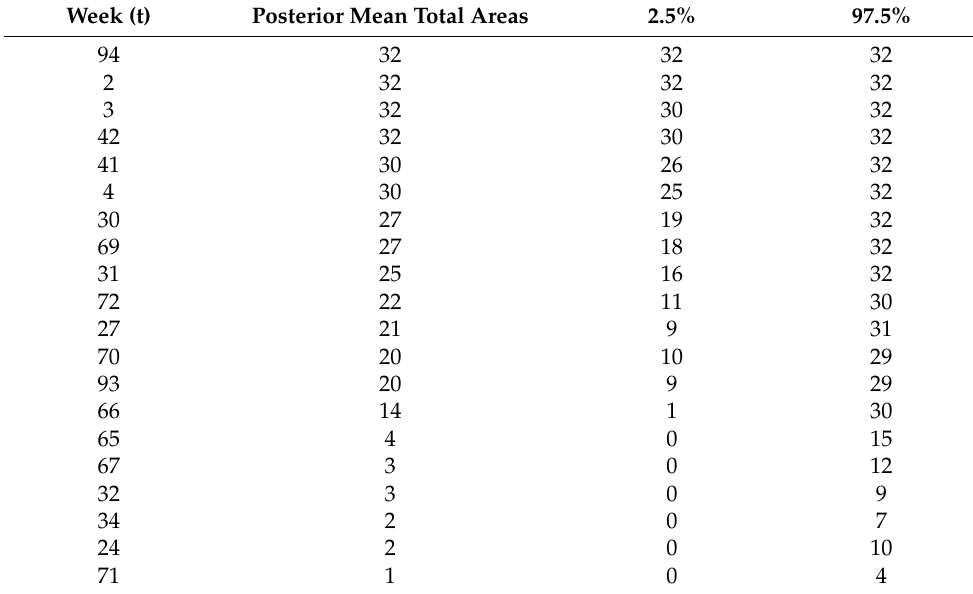
Table 2. Weeks with Highest Growth in Cases, Total Areas (from 32) with ρ it > 1.